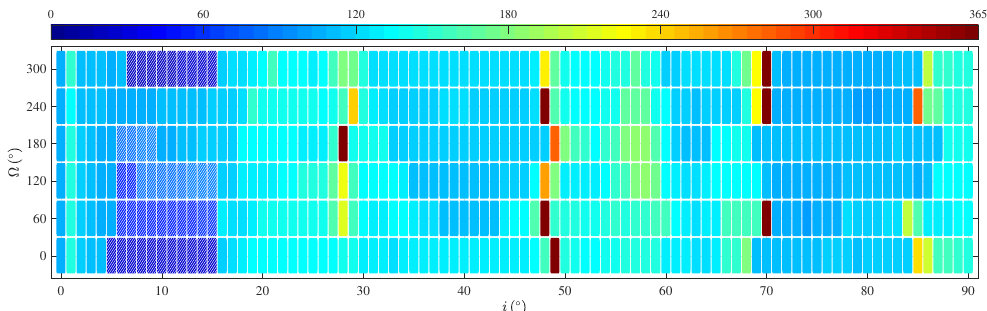
Figure 15. With (cid:107) T (cid:107) = 20 mN, the lifetime of spacecraft in the 40 km-altitude near-circular